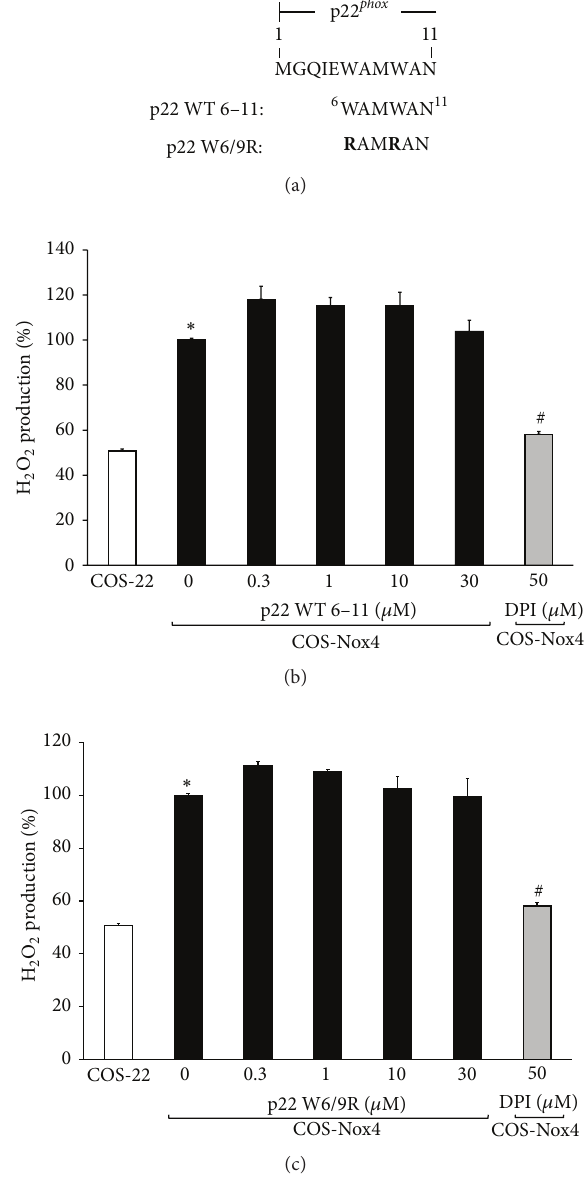
Figure 3: Testing whether p 22 𝑝ℎ𝑜𝑥 N-terminal tail peptides inhibit Nox4 activity. (a) The first 11 amino acids of p 22 𝑝ℎ𝑜𝑥 are displayed. The peptide sequence of p 22 𝑝ℎ𝑜𝑥 between amino acids 6 and 11 is shown (p22 WT 6–11; WAMWAN); point mutations of W6/9R (p22 W6/9R; R AM R AN) are indicated in boldface type. The numbers at the N- and C-terminus of WAMWAN indicate the location of the corresponding residues in the amino acid sequence of p 22 𝑝ℎ𝑜𝑥 . (b) COS-Nox4 cell lysates were preincubated with various concentrations of p22 WT 6–11 for 15min at 24 ∘ C, and H 2 O 2 was measured using Amplex Red. Data represent the mean ± SEM of 3 experiments. (c) COS-Nox4 cell lysates were preincubated with various concentrations of p22 W6/9R for 15min at 24 ∘ C, and H 2 O 2 was measured using Amplex Red. Data represent the mean ± SEM of 3 experiments. ∗ 𝑃 < 0.05 indicates a significant difference between COS-22 and COS-Nox4 cell lysates. # 𝑃 < 0.05 indicates a significant difference between COS-Nox4 + 0 𝜇 M peptide and COS-Nox4 +